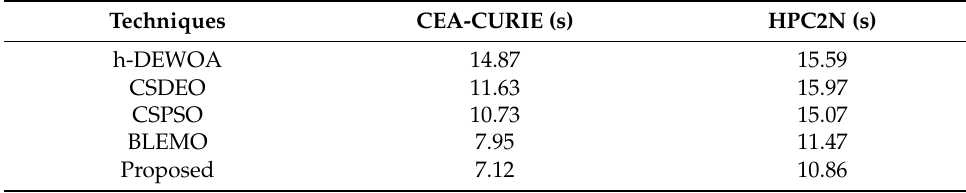
Table 6. Execution time for two